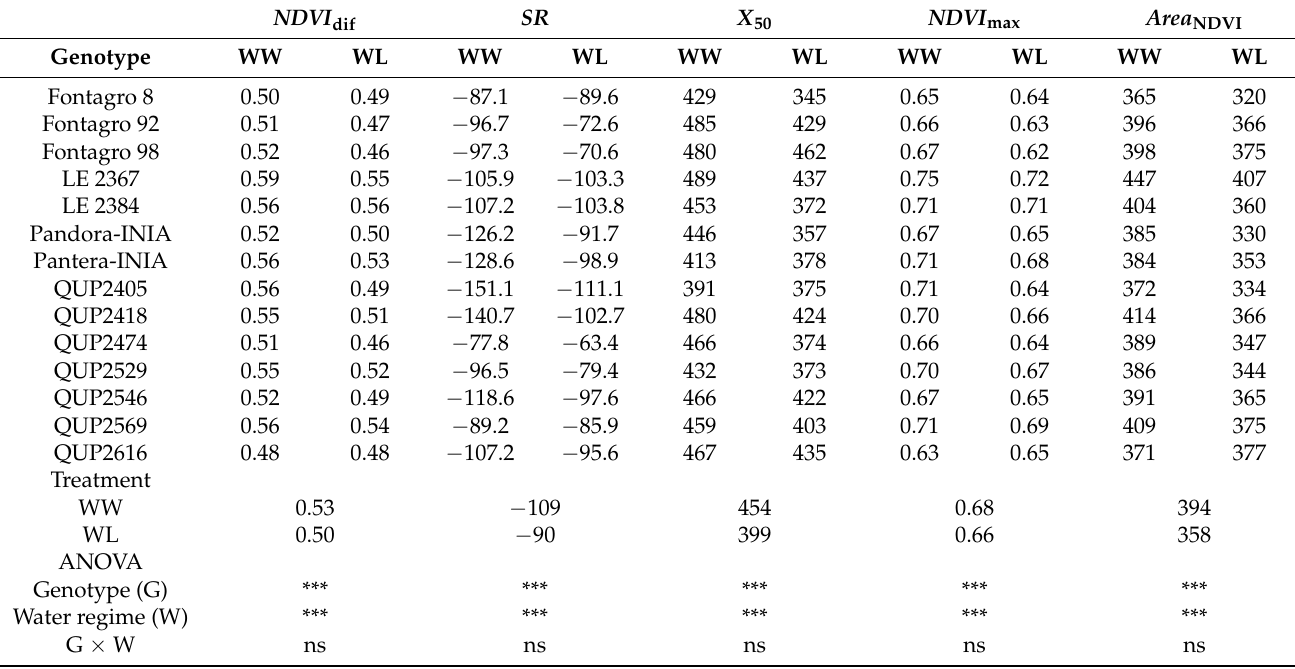
Table 2. Mean values of NDVI dif (NDVI units), SR (NDVI units ◦ Cd − 1 ), X 50 ( ◦ Cd), NDVI max (NDVI units), and Area NDVI ( ◦ Cd) for a set of contrasting spring bread wheat genotypes grown under water-limited (WL) and well-watered (WW) regimes in field conditions. Significance levels for the analysis of variance (ANOVA) are also